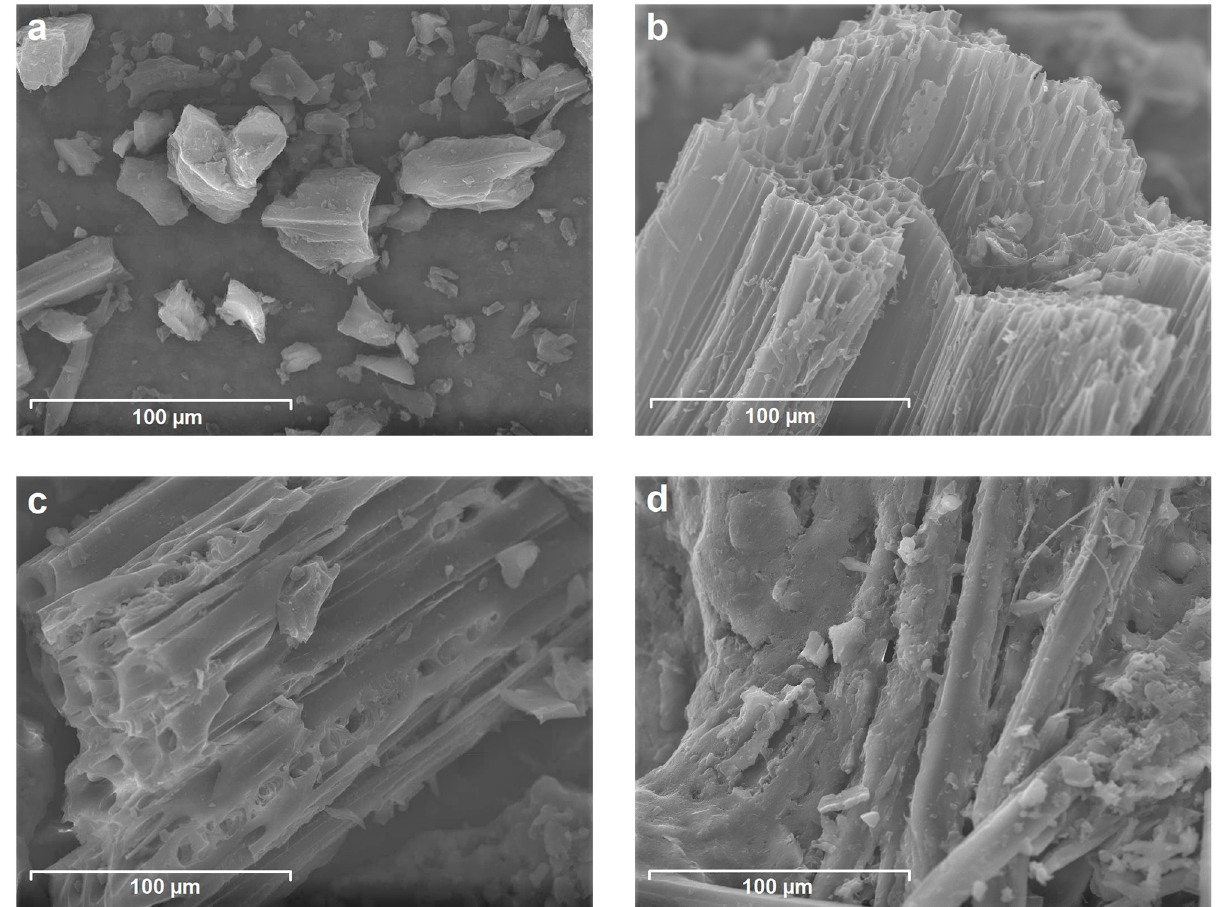
Fig 1. SEM images of selected chars: (a) AC2, (b) PW700g, (c), SW500f and (d) M200h.